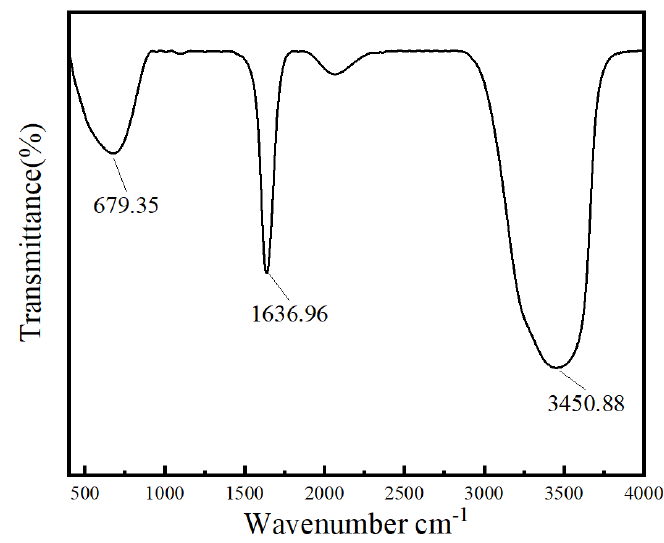
Figure 2. FTIR diagram of polylysine-coated few-layer black scale nanosheets.